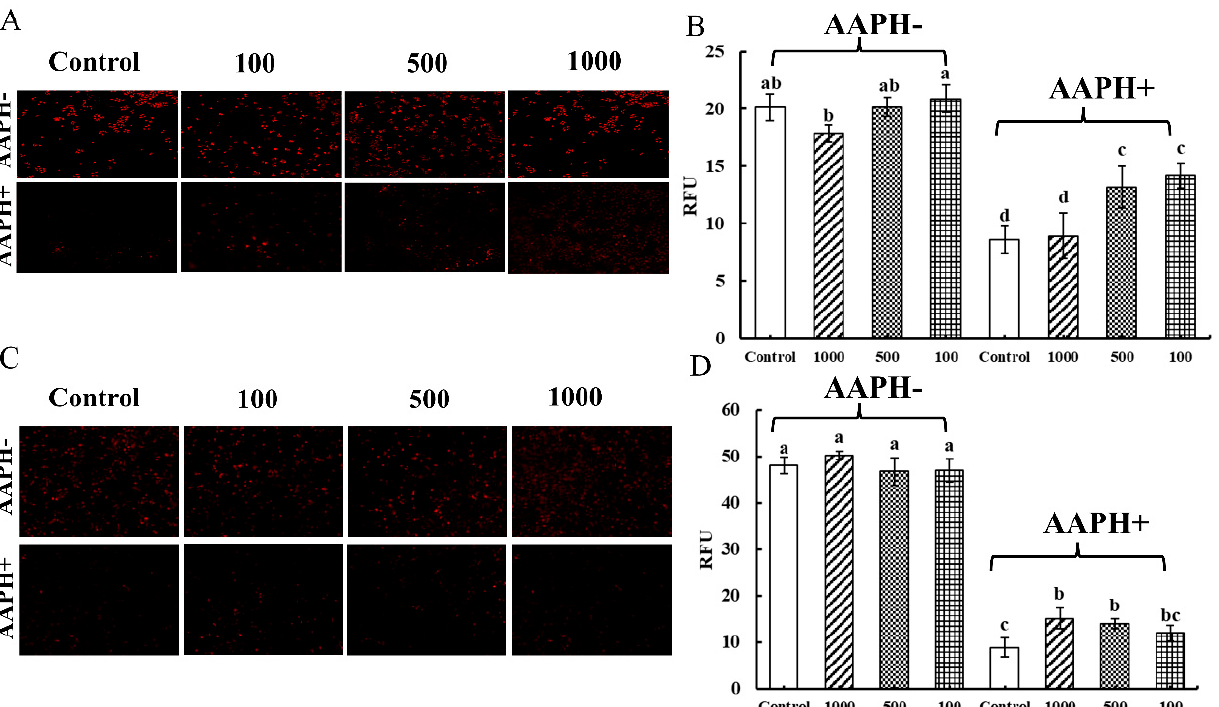
Figure 6. Determination of mitochondrial superoxide content in Caco-2 cells and Raw 264.7 cells. The effect of the CNPs at different concentrations on cell mitochondrial superoxide in Caco-2 cells and Raw 264.7 cells are shown in ( A ) and ( B ), and in ( C ) and ( D ), respectively; different superscript letters indicate significant differences ( p < 0.05).